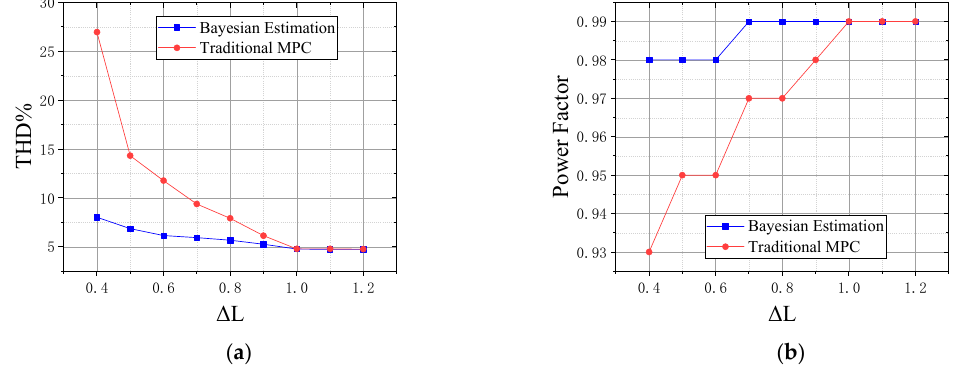
Figure 16. Current harmonic content and power factor in semi-physical test platform under the variation of inductance value. ( a ) AC Current harmonic content; ( b ) AC side Power